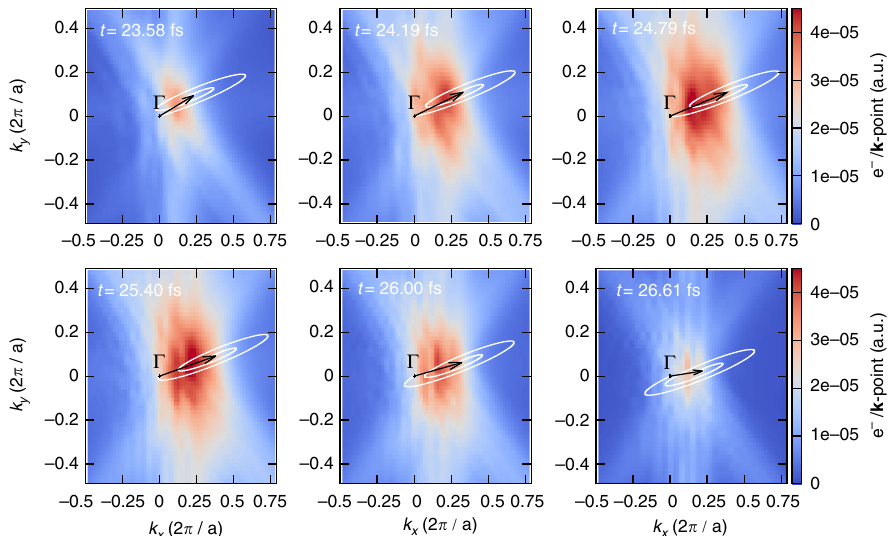
Fig. 4 Dynamics of the excited electrons in momentum space. Comparison of the time evolution of the excited electron wavepacket in momentum space N t ) computed by TDDFT for bulk Si, together with possible positions predicted by the acceleration theorem. The black arrow indicates the direction ex ( k ; and strength of the vector potential. For each time t , the white curve corresponds to all possible center-of-mass positions of the wavepacket, for all possible birth times t b of the wavepacket. The major axis of the polarization ellipse is rotated by θ = +15° around the [001] crystallographic axis